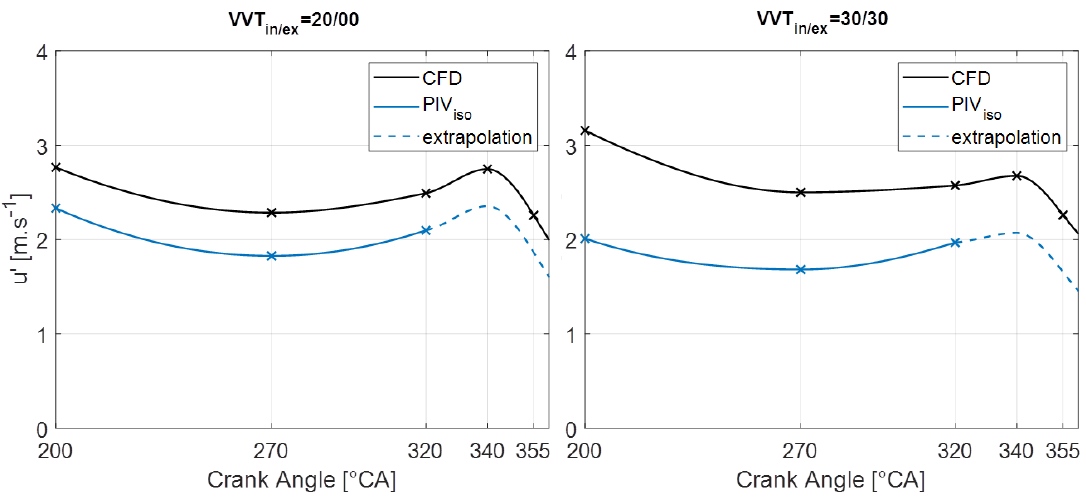
Figure 13. Comparison of the fluctuating velocities between the simulation and experiment .